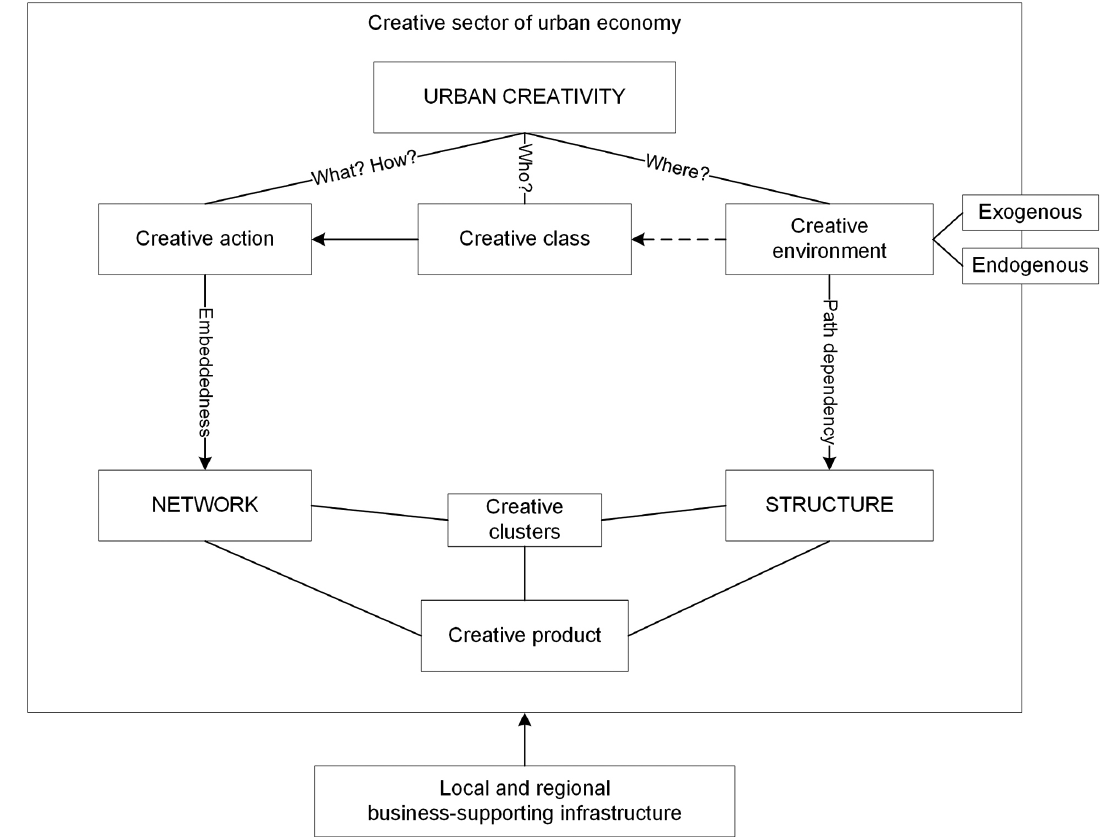
Fig. 1. Conceptual model of the creative sector in the urban economy Source: own